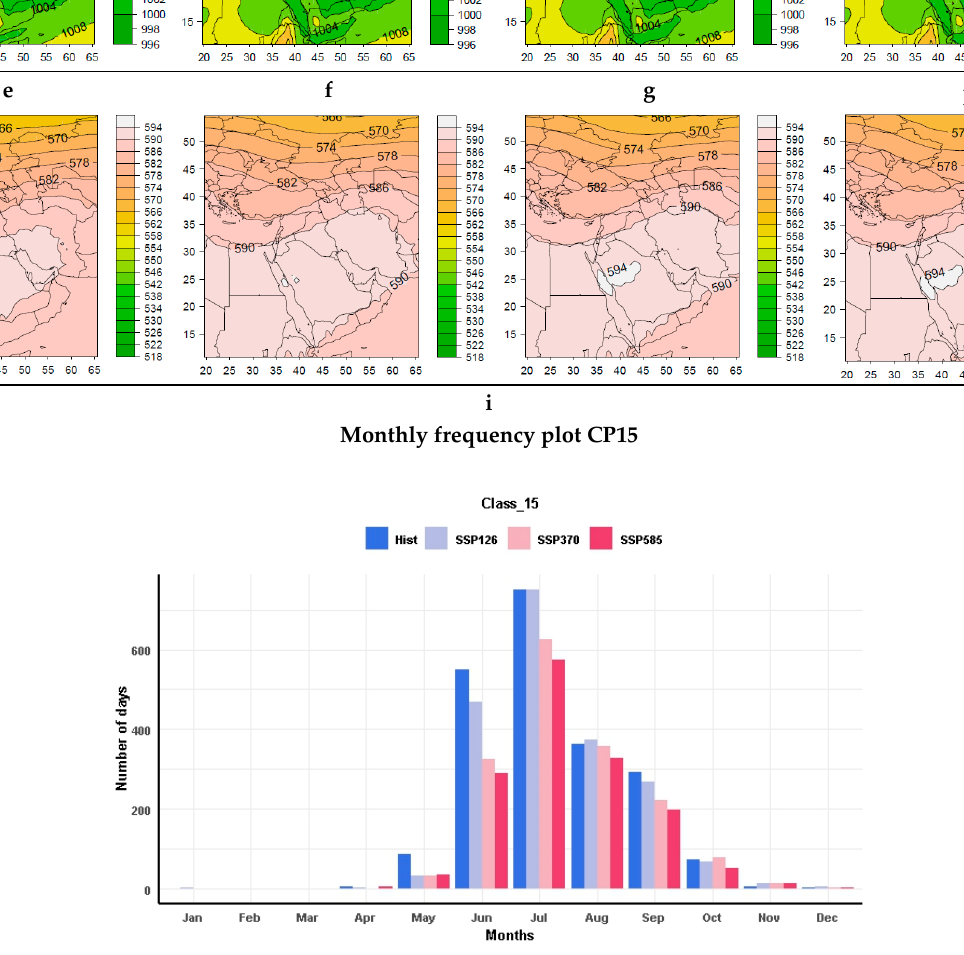
Figure 17. As in Figure 3 for CP15.